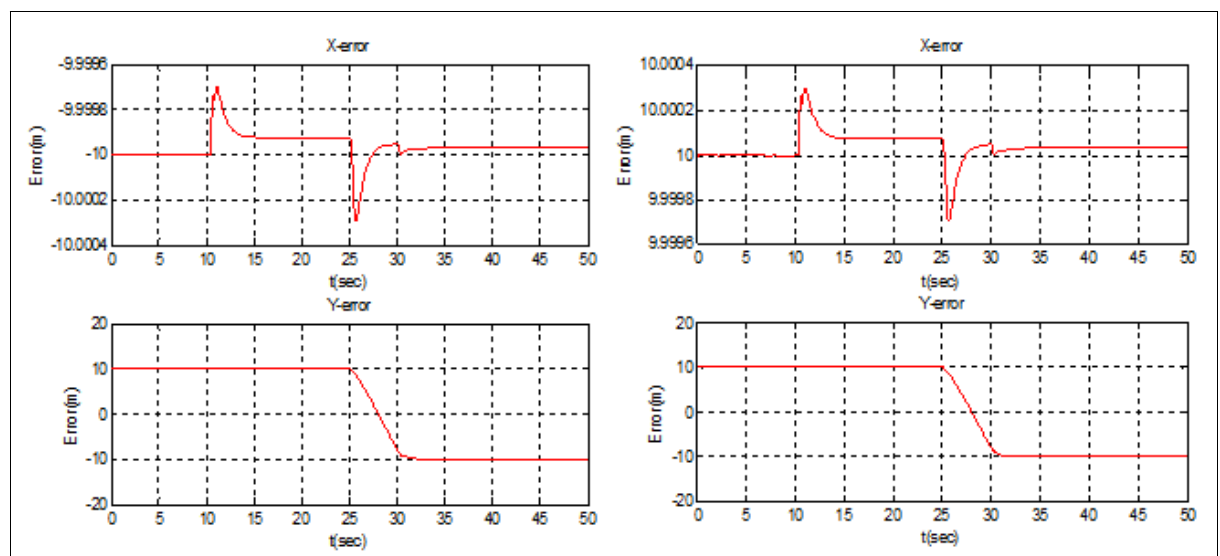
Figure 12. Leader election Case 3—tracking